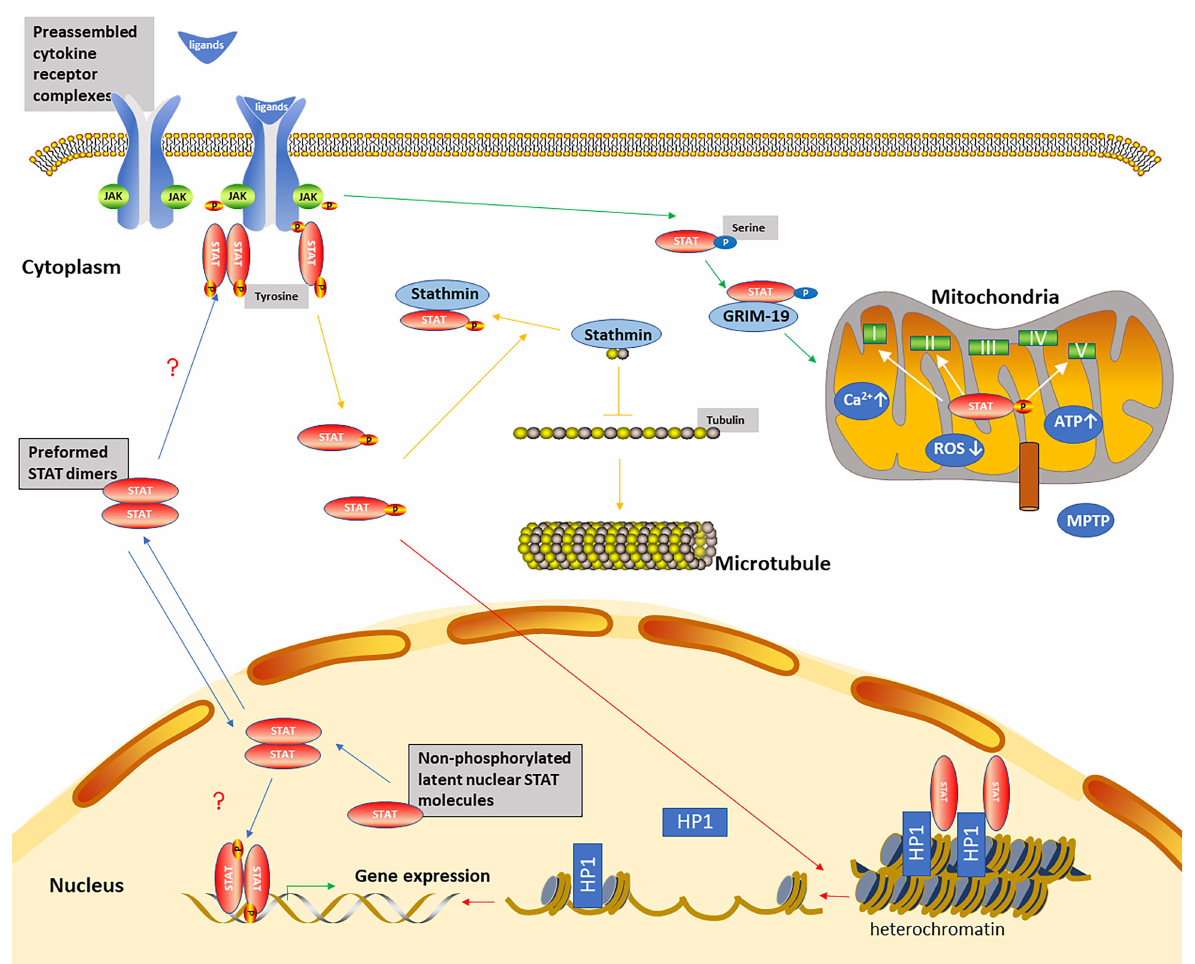
Figure 2. Non-canonical STAT signaling pathways. Non-canonical dynamics aspects (blue lines) include preassembled cytokine receptor complexes in the absence of ligands, preformed STAT dimers in the absence of the activating tyrosine, and non-phosphorylated latent nuclear STAT molecules consistently located in the nucleus. The question marks indicate that the mechanisms are unclear and still need to be further explored. Non-canonical functions include regulation of mitochondria (green lines), microtubule (yellow lines), and heterochromatin (red lines). Tyrosine phosphorylation of STATs promotes their serine phosphorylation. P-Ser-STAT3 is imported into mitochondria via GRIM-19. MitoStat3 promotes ATP synthesis, decreases ROS release, and increases mitochondrial Ca 2+ and MPTP opening through regulating electron transport chains I, II, and V. Stathmin inhibits microtubule growth by binding tubulin dimers and sequestering tubulin, which decreases the concentration of free heterodimers available to polymerization. Phosphorylated STAT3 binding to stathmin inhibits its tubulin depolymerization activity. Unphosphorylated latent STAT binds to HP1 on heterochromatin in the nucleus. Phosphorylated STATs reduce the amount of unphosphorylated STAT localized on heterochromatin. HP1 disassociates from heterochromatin and leads to heterochromatin instability. Genes originally localized in heterochromatin are now accessible to STATs or other transcription